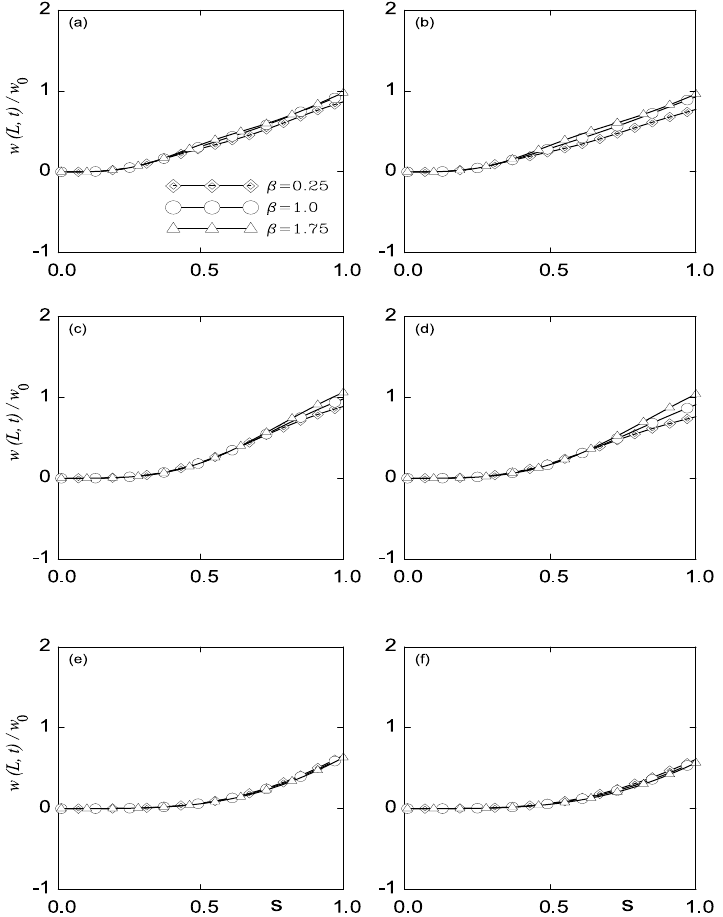
Fig. 4. Dynamic response ( w ( L,t ) /w 0 ) for a fi xed-free beam: (a) α = 0.25, ζ n = 0.1, (b) α = 0.25, ζ n = 0.2, (c) α = 0.5, ζ n = 0.1, (d) α = 0.5, ζ n = 0.2, (e) α = 1, ζ n = 0.1, (f) α = 1, ζ n =